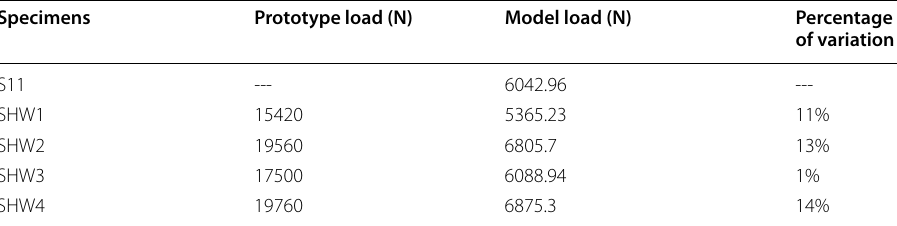
Table 3 Comparison between modal specimen S11 and SHW1 SHW2, SHW3, and SHW4 at a drift percentage of